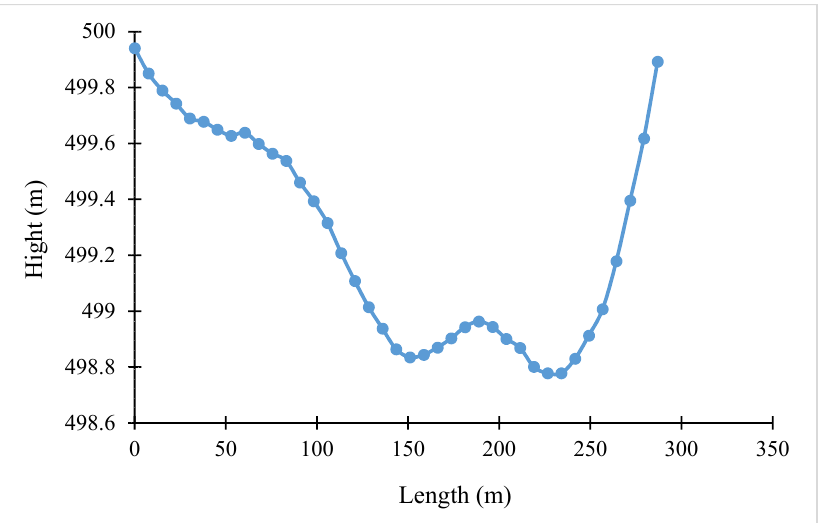
Figure 10. Example of channel cross-sections extracted from the 10 m DEM for the GSSHA model.